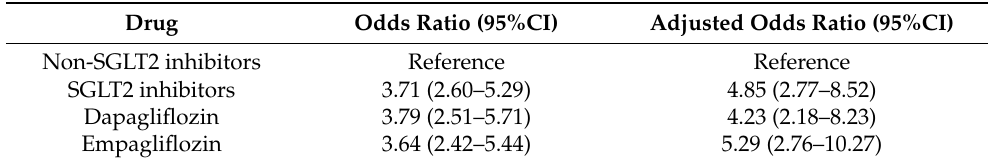
Table 2. Odds ratios of overall urinary tract infection in patients treated with SGLT2 inhibitors compared with patients treated with non-SGLT2 inhibitors.